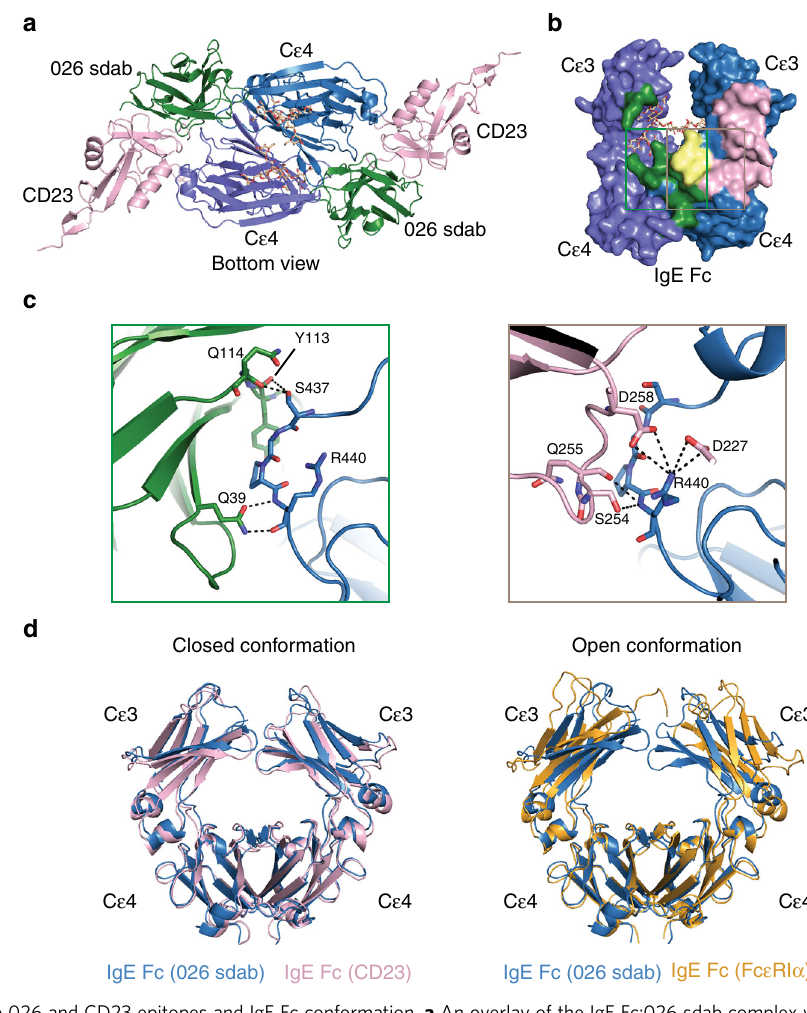
Fig. 3 Comparison of sdab 026 and CD23 epitopes and IgE Fc conformation. a An overlay of the IgE Fc:026 sdab complex with the IgE Fc:CD23 complex shows the proximity of the epitopes of the sdab and CD23. b Surface representation of the IgE Fc with the 026 sdab epitope displayed in green, the CD23 epitope in pink and shared epitope residues in yellow. c Detailed view of the interface between 026 (left) and CD23 (right, PDB ID: 4GKO) and IgE residues 437 – 440. Putative hydrogen bonds or salt bridges are shown as dotted black lines. d Superposition of the IgE Fc domains reveals the similarity of the IgE C ε 3 – 4 closed conformations in the complex with the sdab in blue and CD23 in pink (left) in contrast to the open conformation in the complex with Fc ε RI in yellow (right, PDB ID: